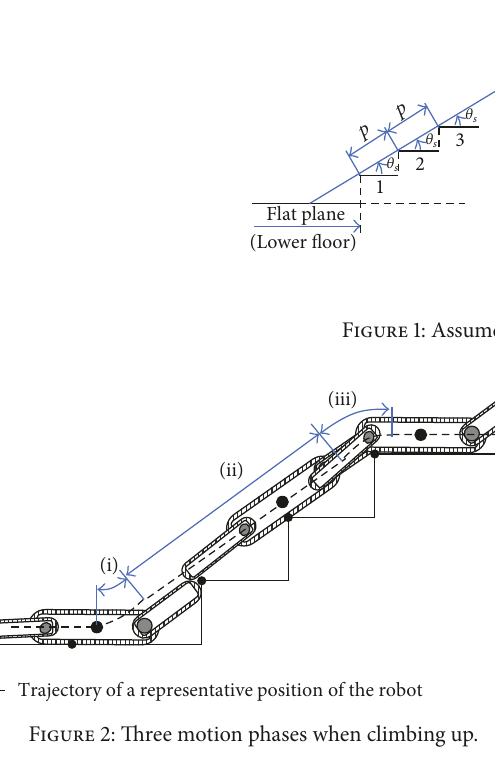
until the inclination of the robot, 𝜃 𝑝 , corresponds to that of the stairs, 𝜃 𝑠 (Figure 2(i)).